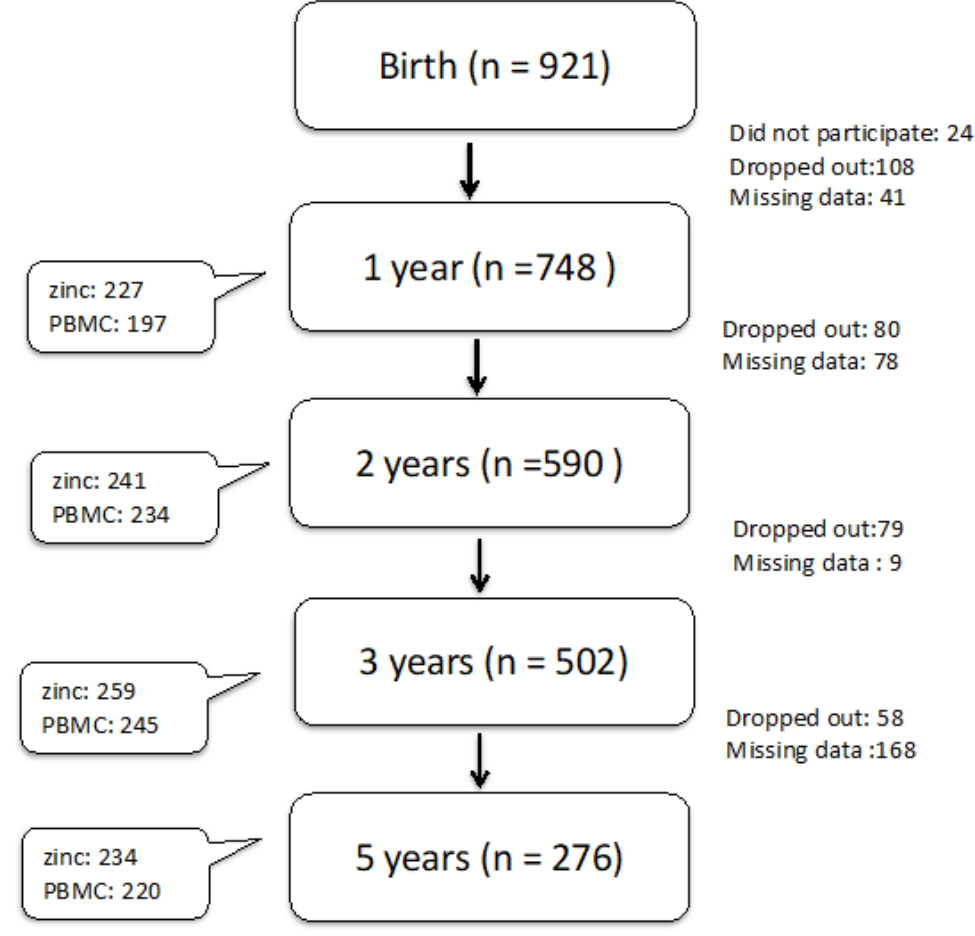
Figure 1. Flowchart of the cohort study: valid questionnaire information and medical records were complete for all children at various ages in the main box. The side box demonstrates the number of blood samples with 1 sample/child at each specific age period for the analysis of zinc and PBMC (peripheral mononuclear cell) isolation for the cytokine stimulation tests. Missing data: mostly because participants missed the clinical visit at that specific age period or clinical data (medical records and/or anthropometric measurements) were